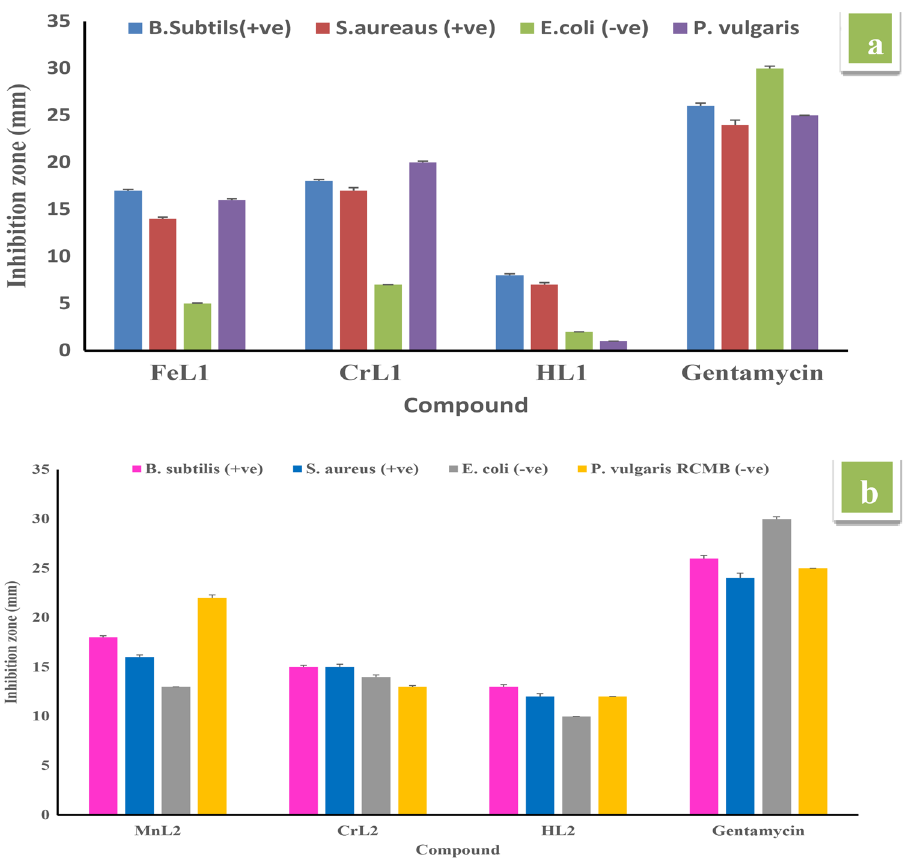
Figure 9. Inhibition zone and their standard deviation values of ( a ) of HL1 ligand and its FeL1 and CrL1 complexes and ( b ) of HL2 ligand and its MnL2 and CrL2 complexes against S. aureus( + ve), B. subtilis ( + ve), P. vulgaris (− ve) and E. coli (− ve) at 20 μg/ml.